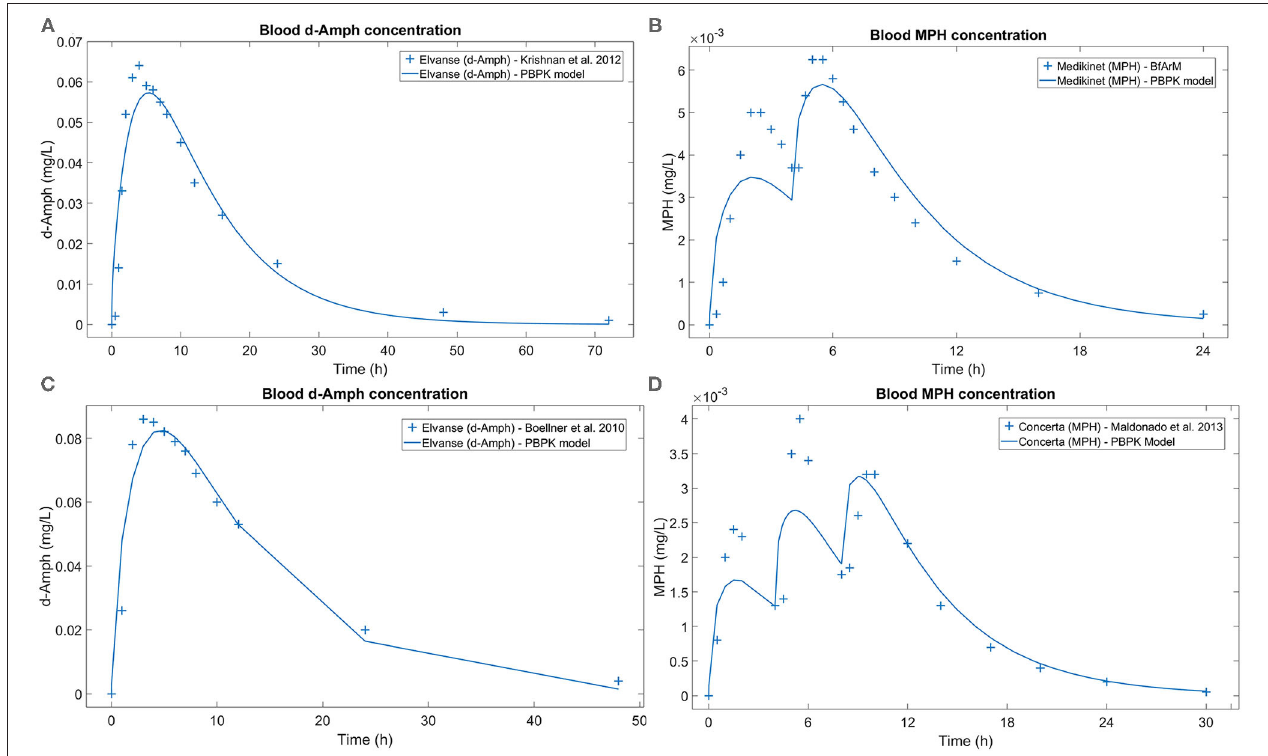
FIGURE 7 | Blood d-Amph and MPH concentration comparison between real datapoints and the curve resulting from the PBPK model. (A) Generated for a standard adult patient after a single 70mg dose of LDX, real datapoints obtained from Krishnan et al. ( 66); (B) generated for a standard adult patient after two 10mg doses of MPH every 4h, real datapoints obtained from BfArM (68); (C) generated for a standard pediatric patient after a single 50mg dose of LDX, real datapoints obtained from Boellner et al. ( 67); and (D) model generated for a standard pediatric patient after three 5mg doses of MPH every 4h, real datapoints obtained from Maldonado et al. ( 69). d-Amph, d-Amphetamine; LDX, Lisdexamfetamine; MPH, Methylphenidate; PBPK, Physiologically based